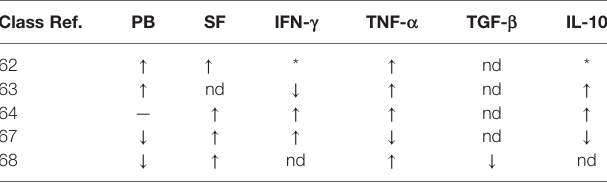
TABLE 1 | The frequency of Treg cells and associated cytokine levels in individuals with RA. Class